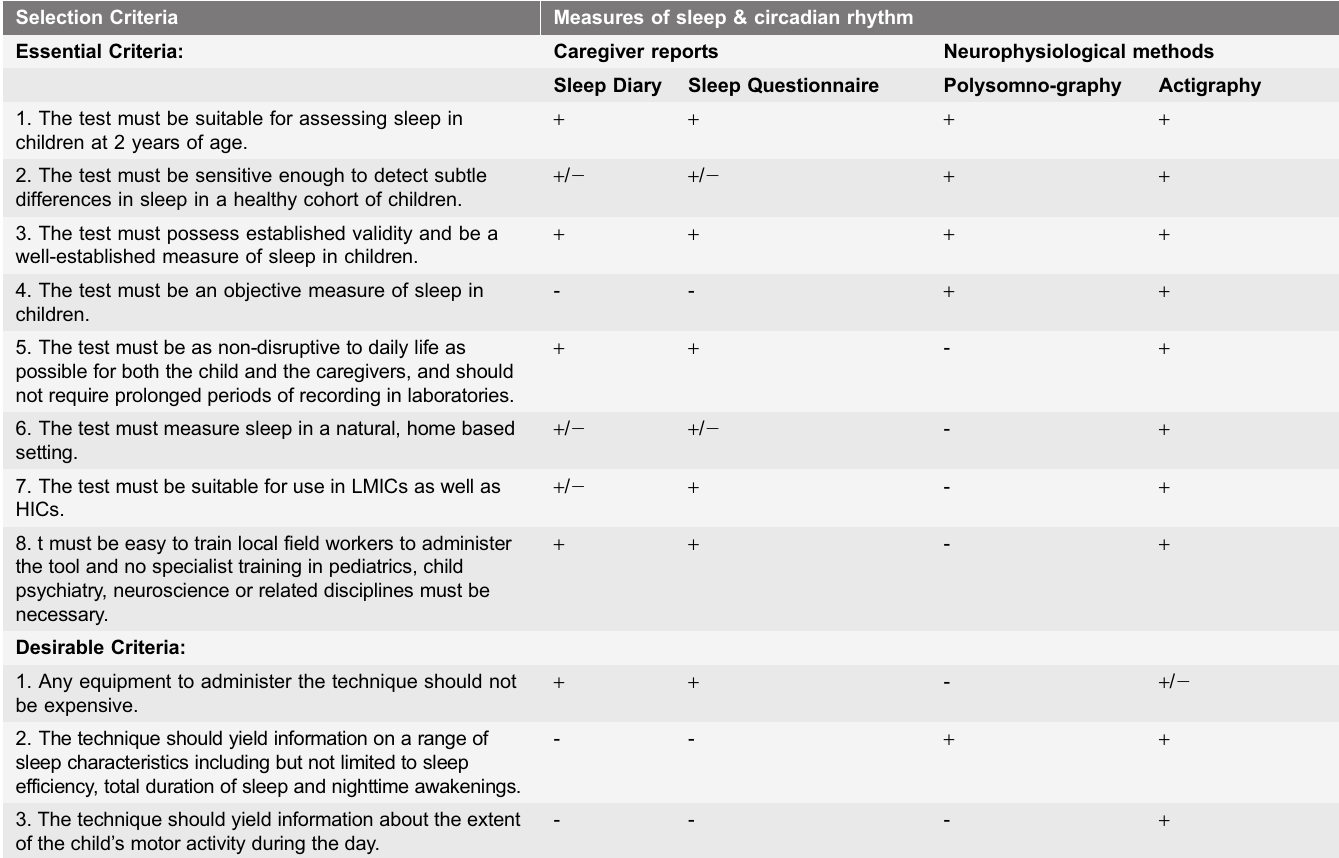
Table 11. Analysis of candidate sleep measures against selection